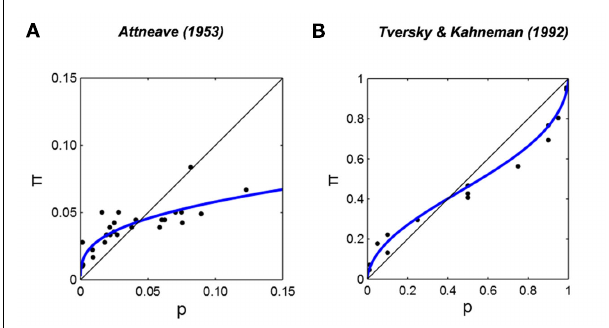
FIGURE 1 | S-shaped distortions of frequency estimates. (A) Estimated relative frequencies of occurrence of English letters in text plotted versus actual relative frequency from Attneave (1953). (B) Subjective probability of winning a gamble (decision weight) plotted versus objective probability fromTversky and Kahneman (1992). R 2 denotes the proportion of variance accounted by the fit.